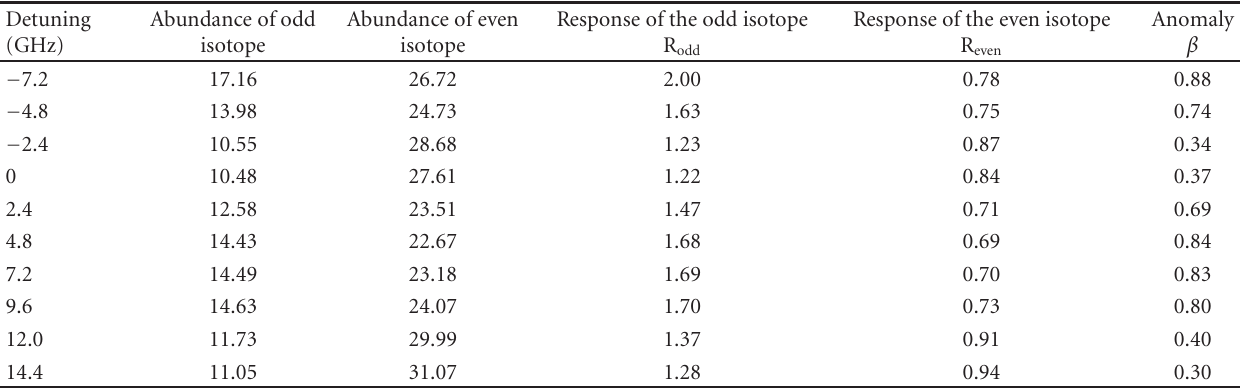
Table 8: A table of the theoretically determined percentage anomaly ( β ) as a function of laser intensity in the anticollinear-RIMS of tin isotopes for a laser linewidth of 15 GHz and a residual Doppler width of 2GHz. Isotope